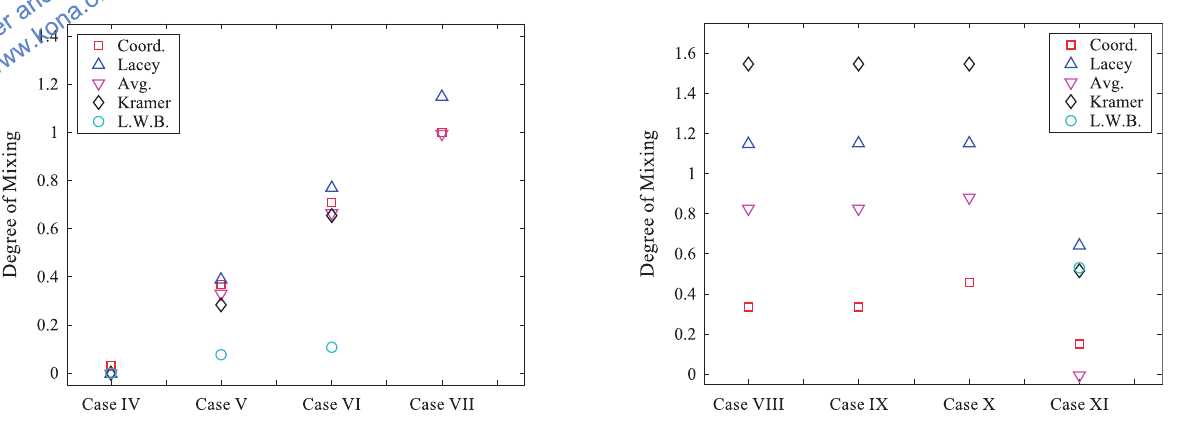
Fig. 8 The degree of mixing for different mixing indices for series B. The size of cell size is n = 8.